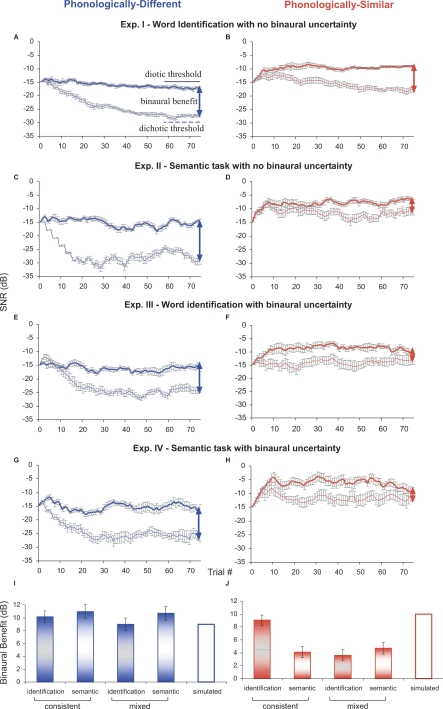
Results of Study 1, Experiments I–IVLeft: results using phonologically different word pairs (blue). Right: results using phonologically similar pairs (red). (A–H) The dynamics of the adaptive threshold assessment as a function of trial number (averaged across subjects ± SEM, n = 10 for each of the eight conditions). The level of the signal was modified in relation to subject's performance (following a three down–one up adaptive procedure). Illustrations of diotic (thick curves) and dichotic (thin curves) thresholds, which are calculated as the mean of last five reversals (see Materials and Methods), are marked by dashed lines in (A). Thresholds are denoted in decibel SNR. Binaural benefits (vertical arrows in all panels) are calculated as the difference between the diotic and dichotic thresholds.(A and B) Experiment I: the identification task with no binaural uncertainty (consistent binaural protocol).(C and D) Experiment II: the semantic task with no binaural uncertainty (consistent binaural protocol.(E and F) Experiment III: the identification task with binaural uncertainty (mixed binaural protocol).(G and H) Experiment IV: the semantic task with binaural uncertainty (mixed binaural protocol).(I and J) A summary of the average binaural benefits obtained in Experiments I–IV (filled shaded bars), and the benefits calculated by an ideal listener model (open bars; see Figure S2 and Text S1), for phonologically different (left, [I]) and phonologically similar (right, [J]) pairs.